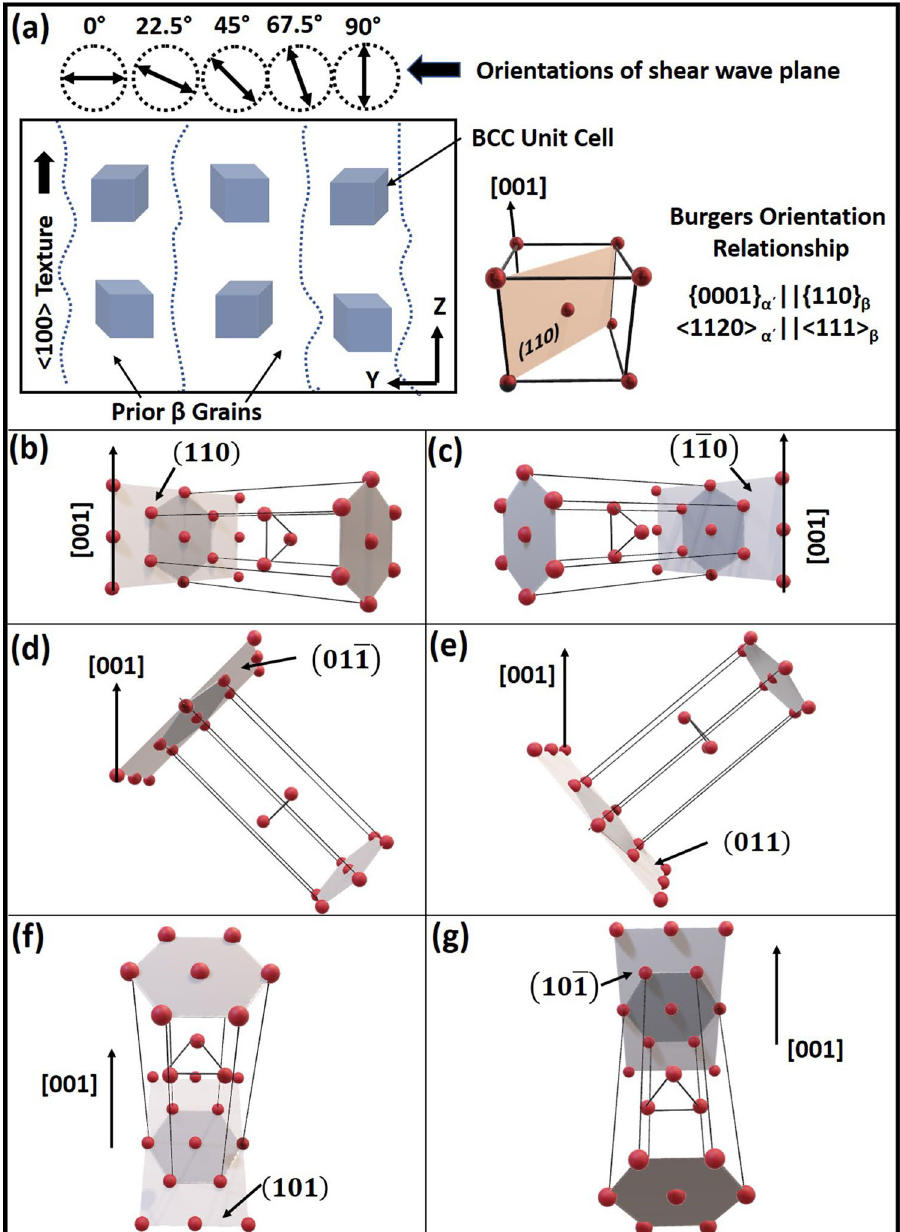
Figure 5. Schematics of ( a ) prior β grains and ( b ) BCC unit cell with ( c – g ) possible variants of α ′ martensite HCP unit